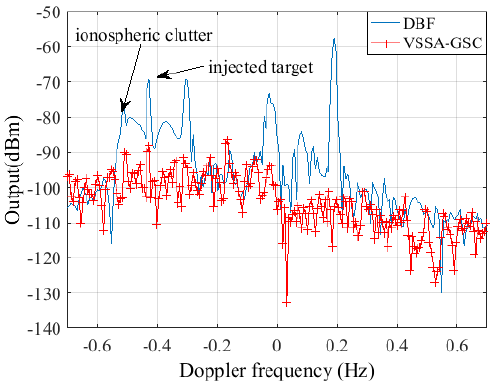
Figure 8. Doppler frequency profiles with DBF and VSSA-GSC